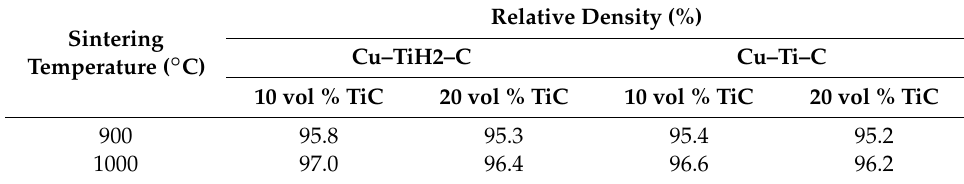
Table 3. Relative density of Spark plasma sintered Cu–TiH2–C and Cu–Ti–C nanocomposites. Sintering